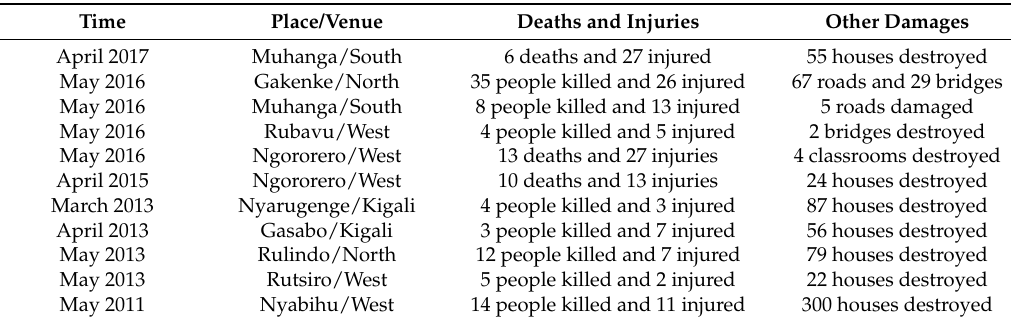
Table 1. Latest main disasters caused by landslides s in